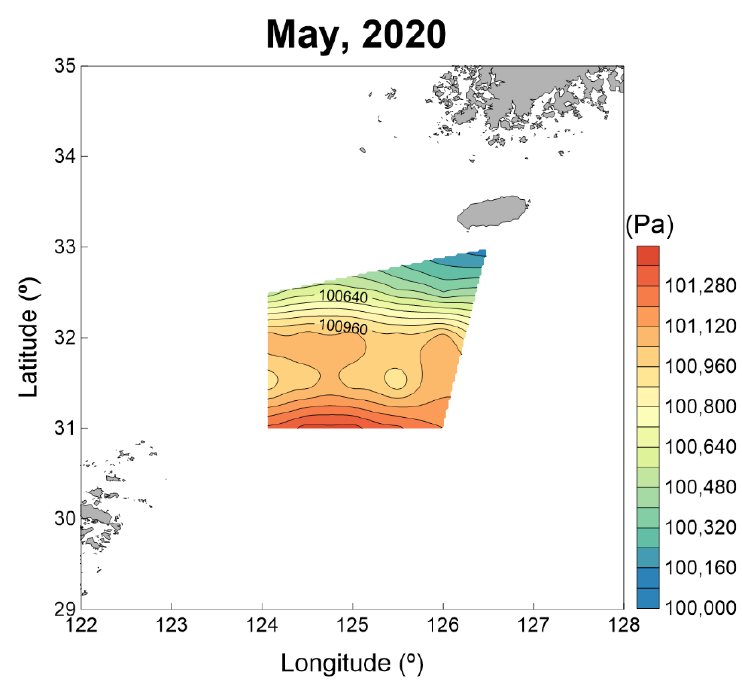
Figure 9. Distribution of atmospheric pressure in the East China